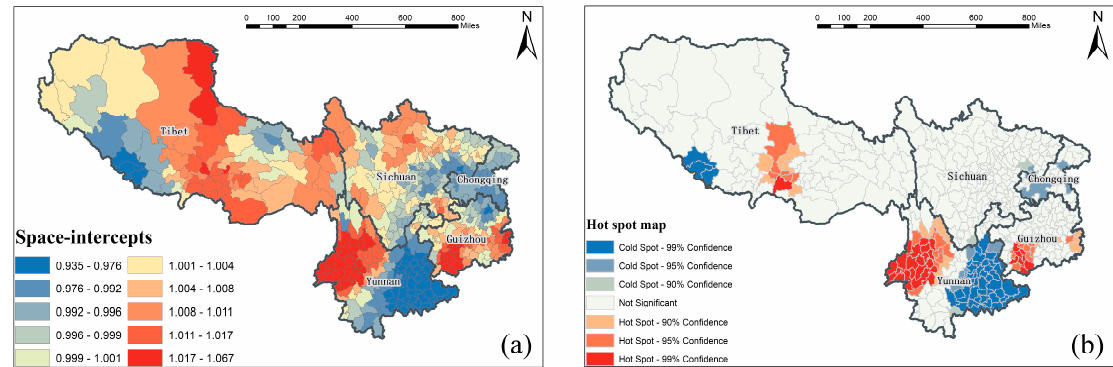
Figure 4. ( a ) Space-intercepts (SI) map representing the crude geographical distribution of the county-level hospital beds across southwest China, and ( b ) SI’s clustered hot spot map.